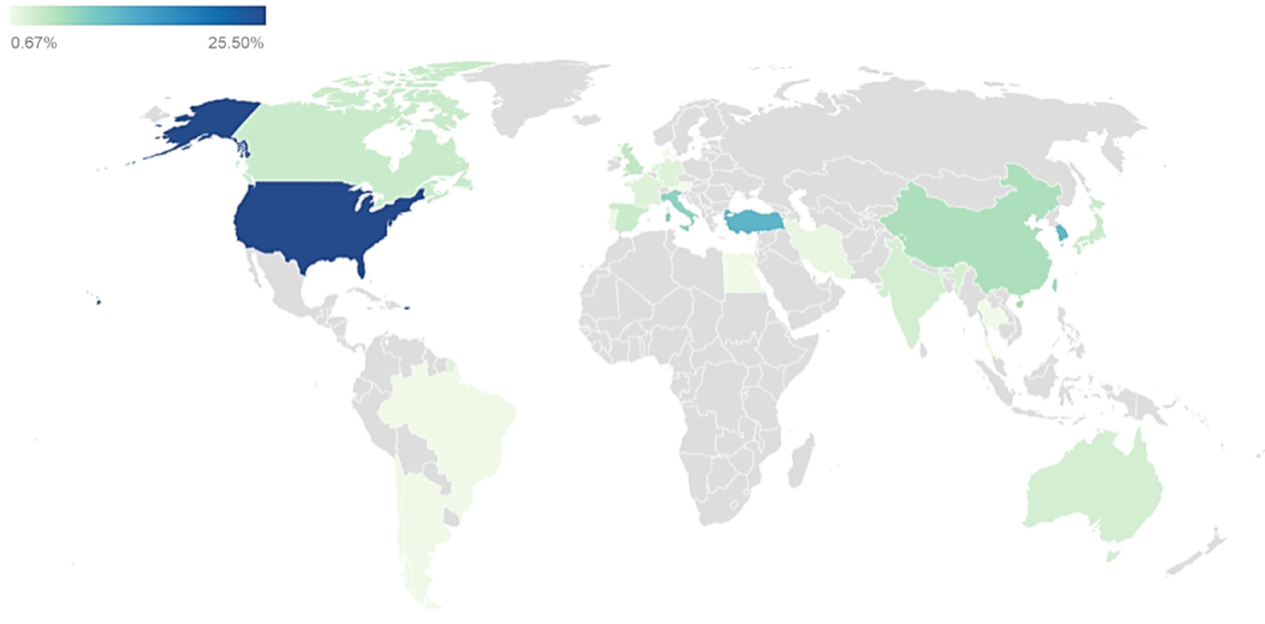
Figure 4. Geographical origin of the papers. The colors represent the percentage of the frequency of each country. The grey territories do not have any paper. The map was created by Datawrapper.